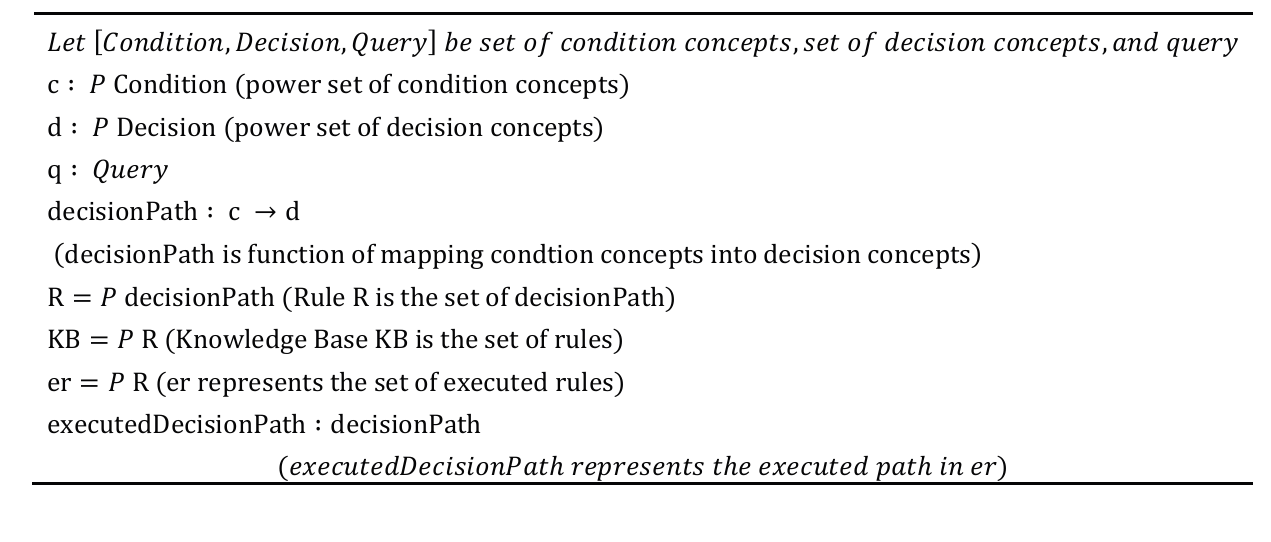
Table 2. Formal representation of query